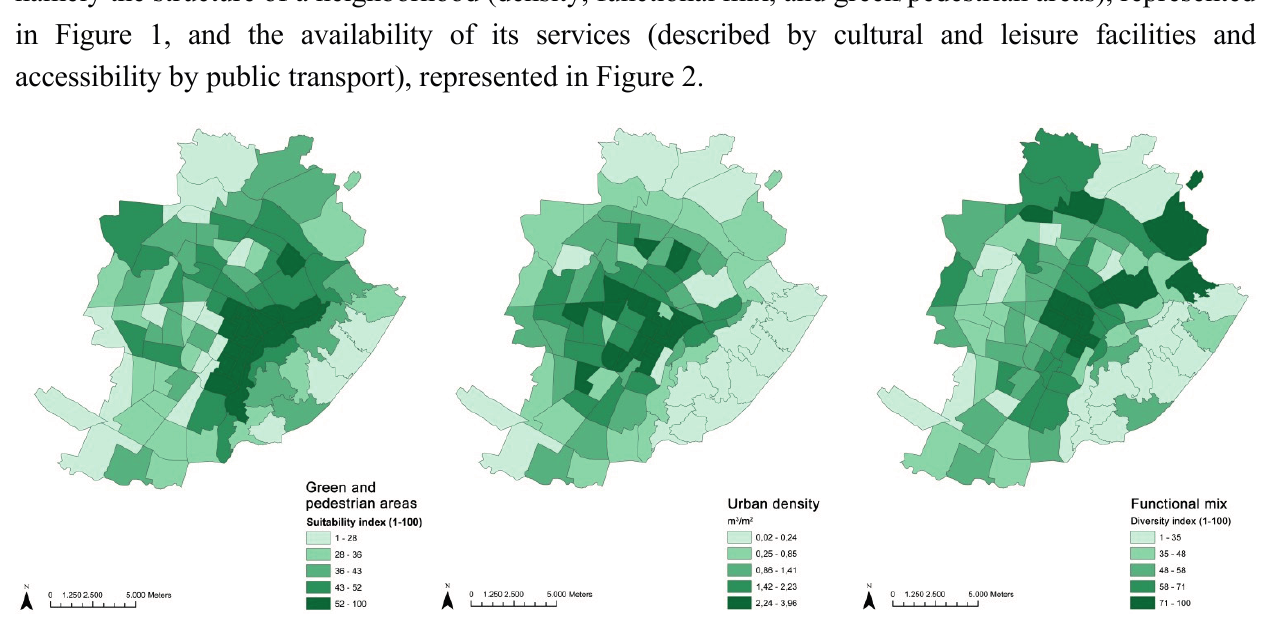
Figure 1. Distribution of BE structural variables.